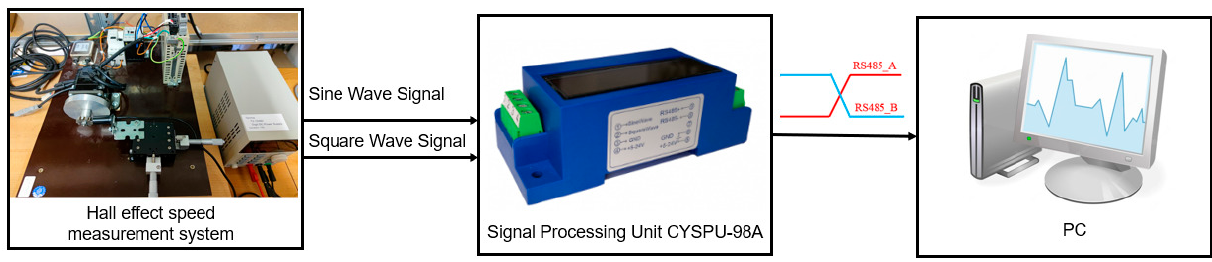
Figure 11. Block diagram of a Hall effect gear tooth sensor-based frequency test system.